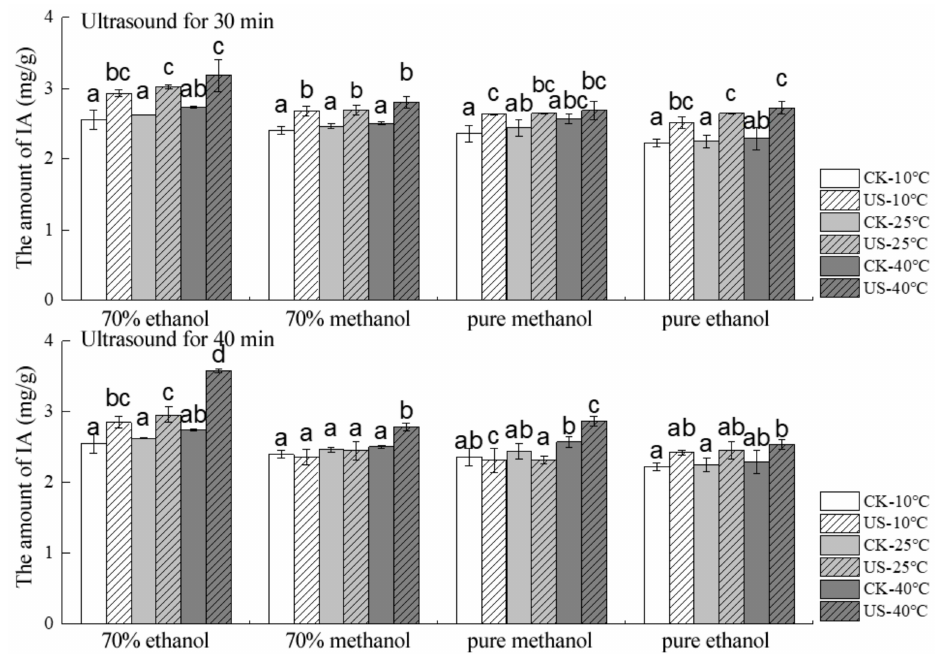
Figure 3. E ff ect of temperature on the stability of individual anthocyanin in blueberry pomace under ultrasound treatment and conventional solvent extraction. Di ff erent letters on bars show significant di ff erences ( p <